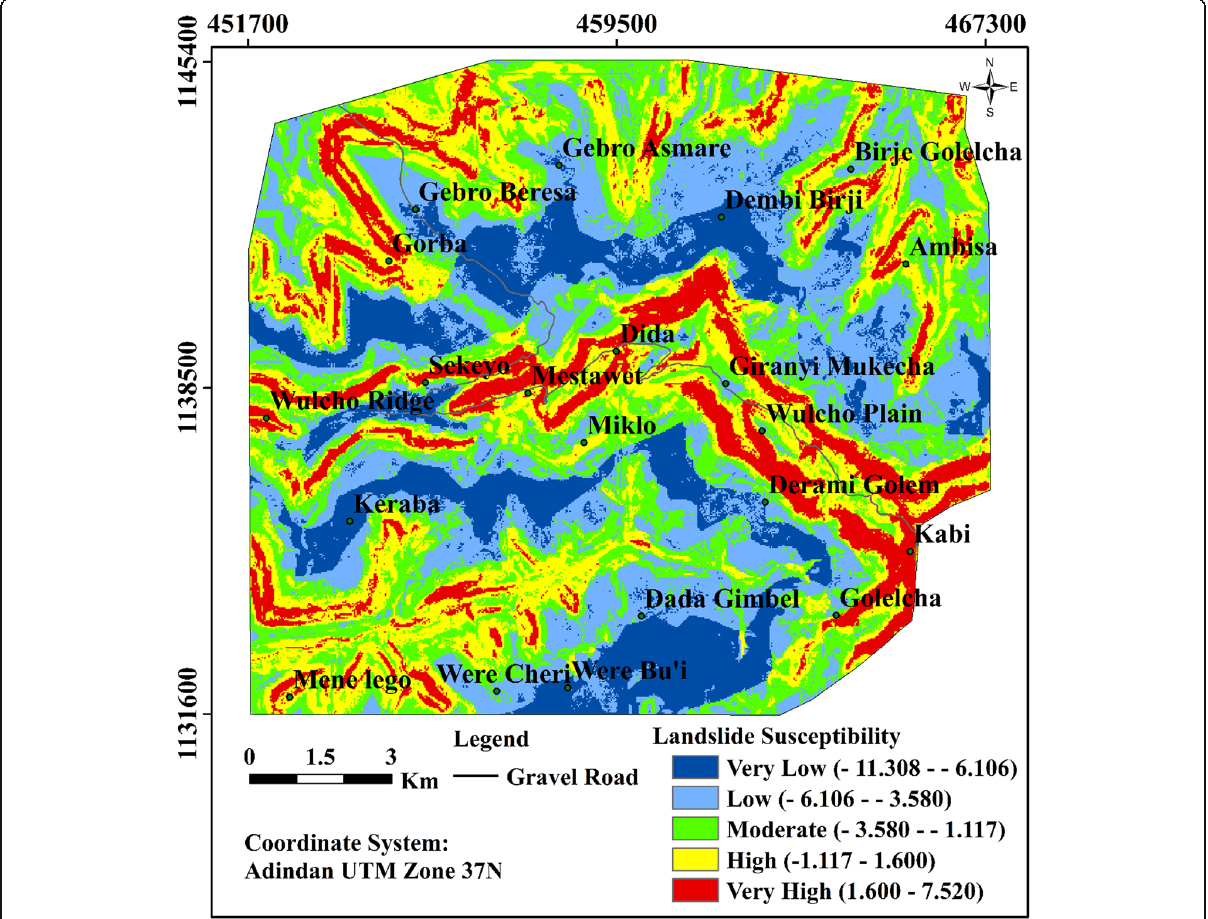
Fig. 8 Landslide susceptibility map of the study